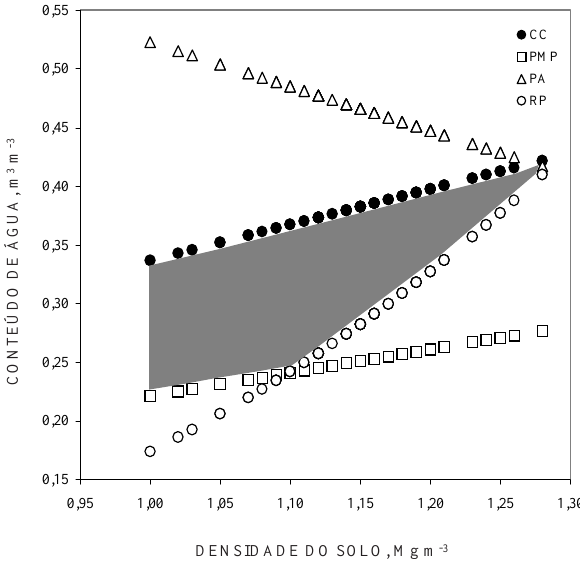
Figura 1. Variação do conteúdo de água com a densidade nos níveis críticos da capacidade de campo (CC ou yyyyy = -0,01 MPa), ponto de murcha (PMP ou yyyyy = -1,5 MPa), porosidade de aeração de 10% (PA) e resistência à penetração de 2,0 MPa (RP). A área hachurada representa o Intervalo Hídrico Ótimo do Solo